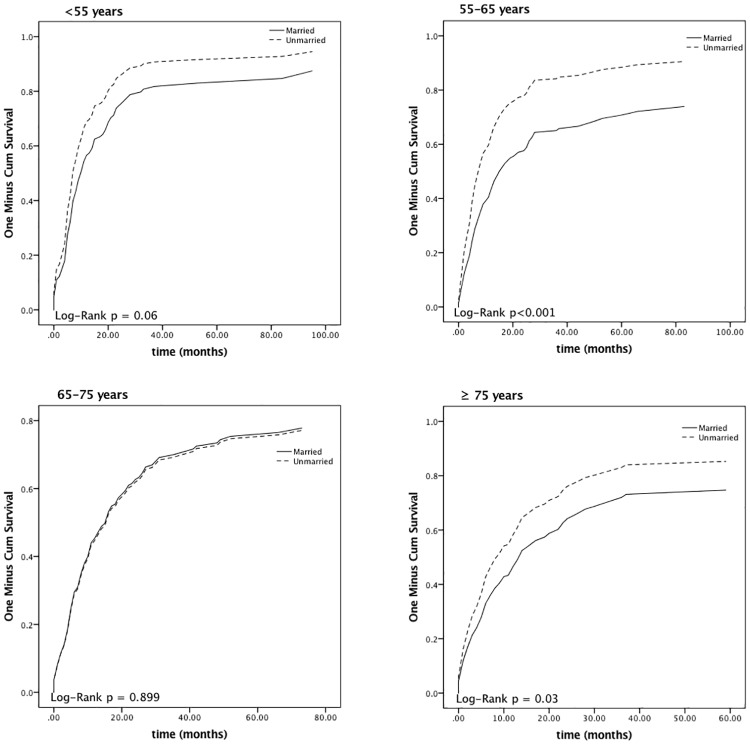
Kaplan—Meier survival curves for patients with different marital status stratified by various age groups.